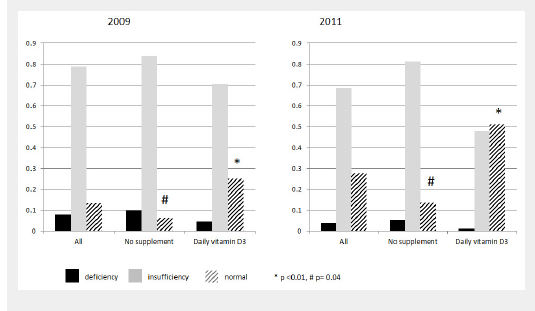
Effects of vitamin D3 supplementation: X-axis: 3 groups: all patients, nonsupplemented patients and patients with daily supplement of vitamin D3; Y-axis: percentage of patients with deficiency, insufficiency or normal results (1 = 100%); * and #: comparison between 2009 and 2011, the number of patients with normal results being significantly higher in